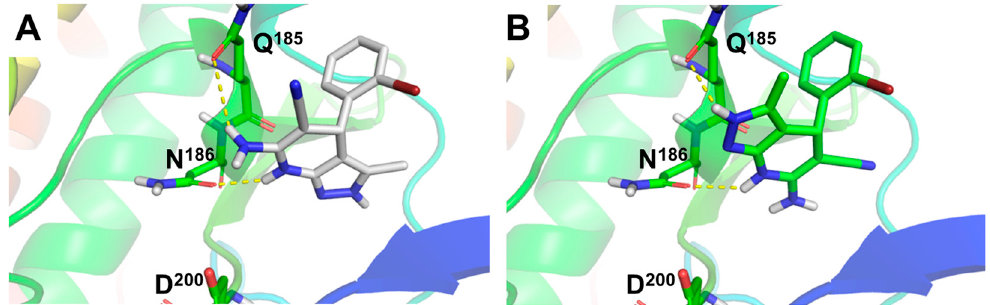
Figure 1. Molecular docking of compound 4f (Ar = 2-BrPh), ( R )- and ( S )- enantiomers, at the adenosine triphosphate (ATP) binding site of GSK-3 β . ( A ) Predicted binding mode for 4f ( R )-enantiomer and ( B ) ( S )-enantiomer represented as white and green sticks, respectively. Hydrogen bond interactions showed as yellow dotted lines. GSK-3 β protein (PDB-ID: 3I4B) represented as colored cartoon and key residues as colored sticks.